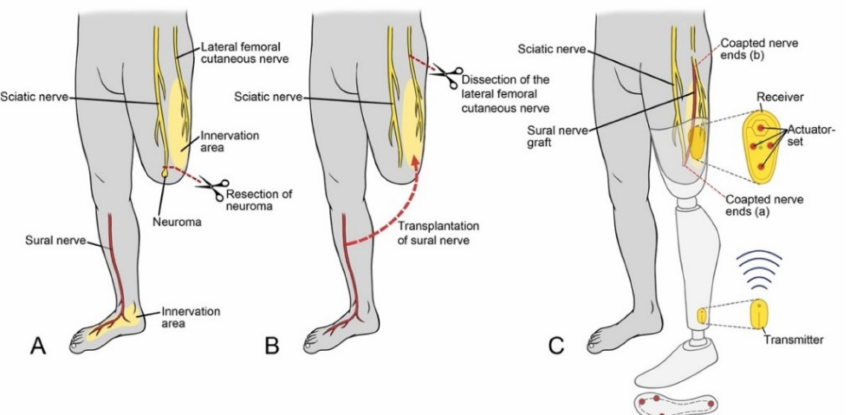
Figure 3. Illustration of the surgical technique for a transfemoral amputation: ( A ) resection of the stump neuroma; ( B ) transplantation of the contralateral sural nerve as an autologous graft from the distal stump of the sciatic nerve to the cutaneous territory of the lateral femoral cutaneous nerve; ( C ) the medical device Suralis in place, providing sensory feedback from the sole to the reinnervated skin